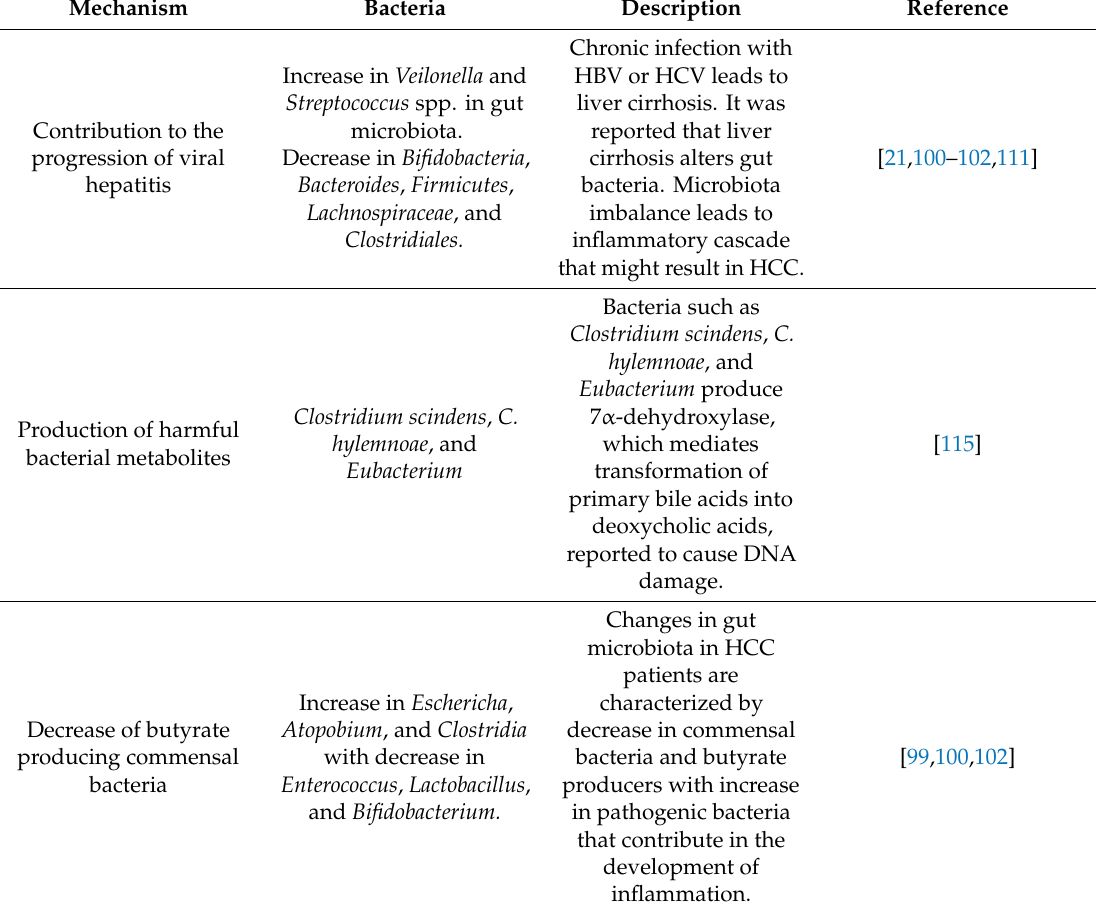
Table 5. Impact of gut microbiota on liver cancer. HBV, hepatitis B virus; HCV, hepatitis C virus; HCC, hepatocellular